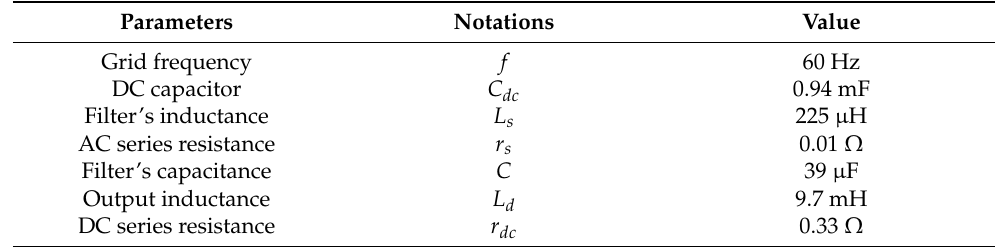
Table 3. Parameters of the buck-type current-source rectifier.